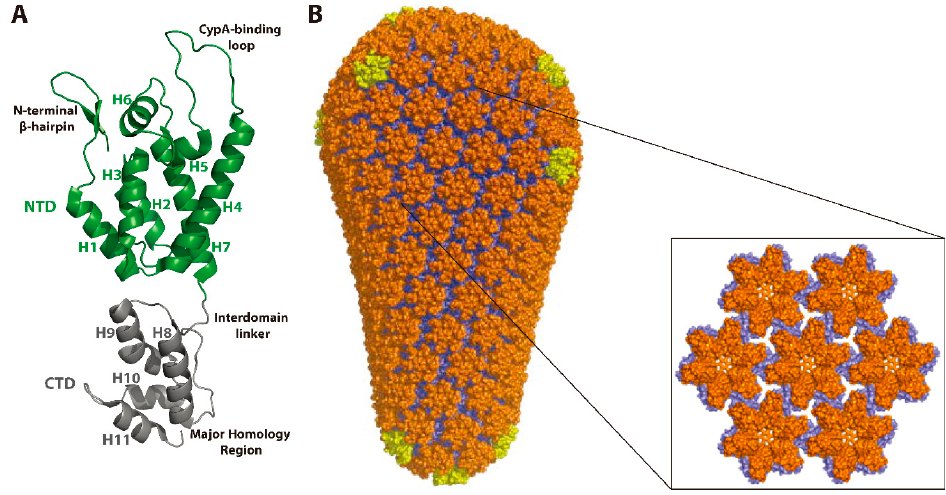
Figure 3. The HIV-1 capsid. During maturation, proteolytic processing of the Gag polyprotein liberates the mature CA protein. ( A ) The monomeric CA (PDB accession 2M8N) is a predominantly α -helical protein with N- and C-terminal domains (CA-NTD and CA-CTD, respectively) connected by a flexible interdomain linker region. Individual α -helices are indicated (H1-H11) and the locations of key structural elements (e.g., the N-terminal β -hairpin, CypA-binding loop, interdomain linker, and major homology region) are labeled. ( B ) In the final stage of maturation, CA monomers multimerize into hexameric (orange) and pentameric (yellow) subunits that assemble into a conical structure exhibiting fullerene geometry. This protein superstructure, known as the capsid, contains approximately 250 CA hexamers and exactly 12 CA pentamers. The incorporation of pentameric subunits is concentrated at either end of capsid to provide the curvature necessary to close this structure. The CA-NTD is labeled in orange and the CA-CTD in blue. Panel B images are reprinted with permission from the authors of references [6] and [33] and from Cell Press and Nature Publishing Group.